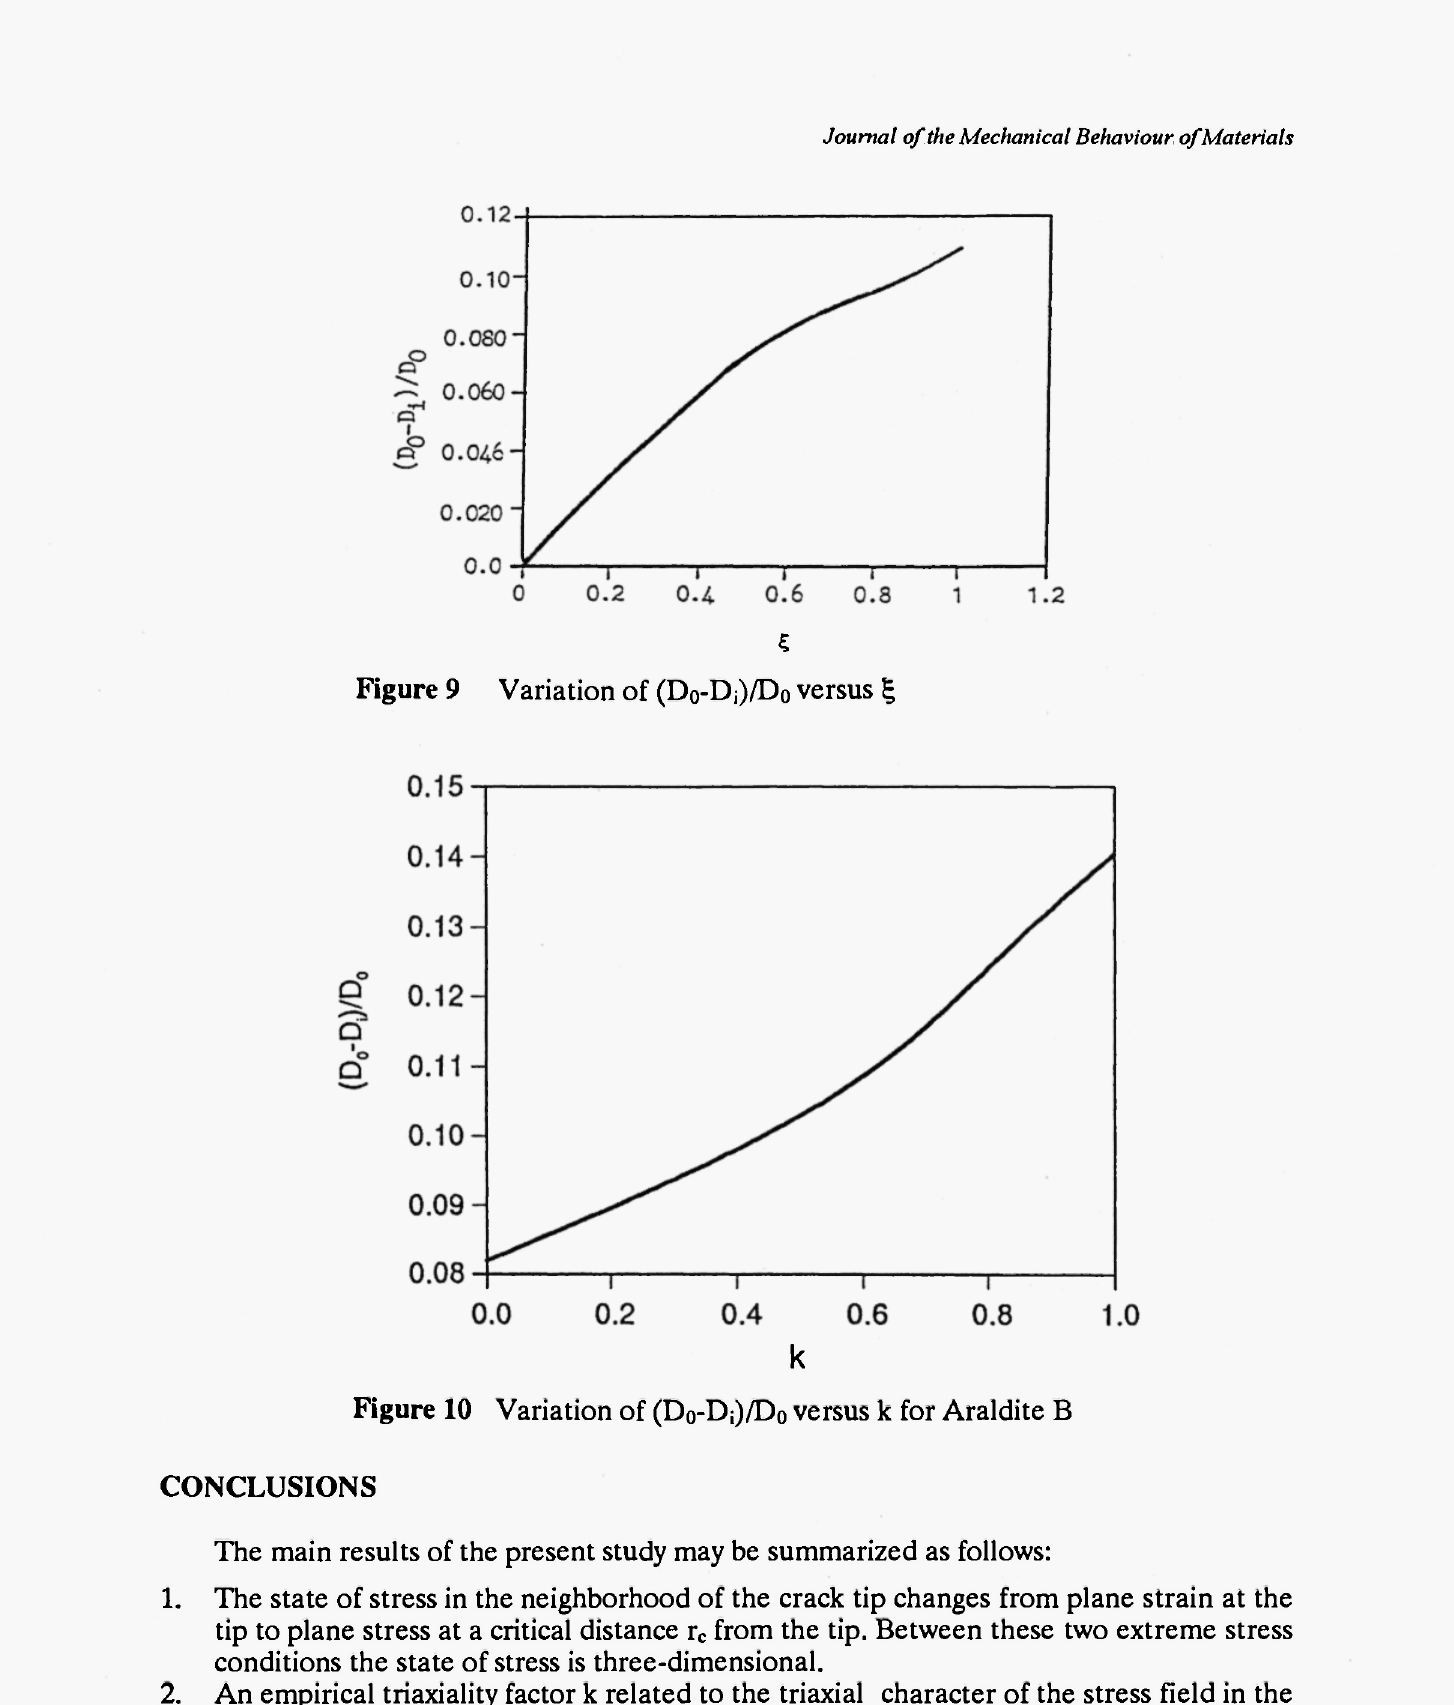
k -Di)/D versus k for Araldite 0 0